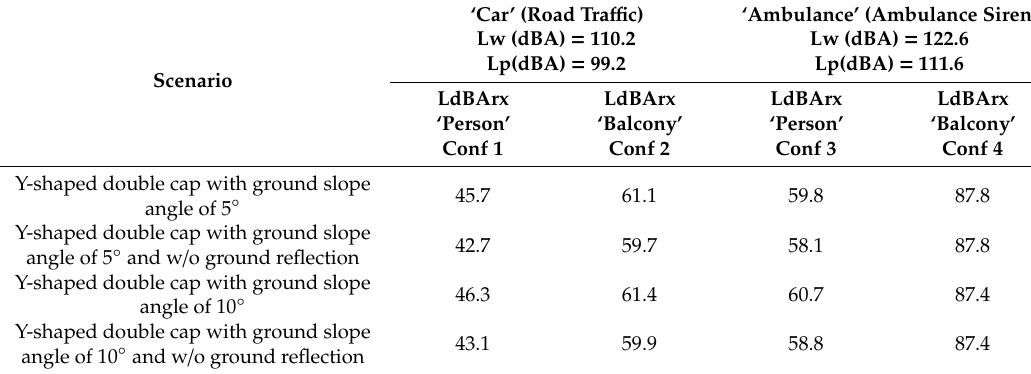
Table 2. Global SPL (dBA) at the receiver positions for Y-shaped double cap and sloping ground.